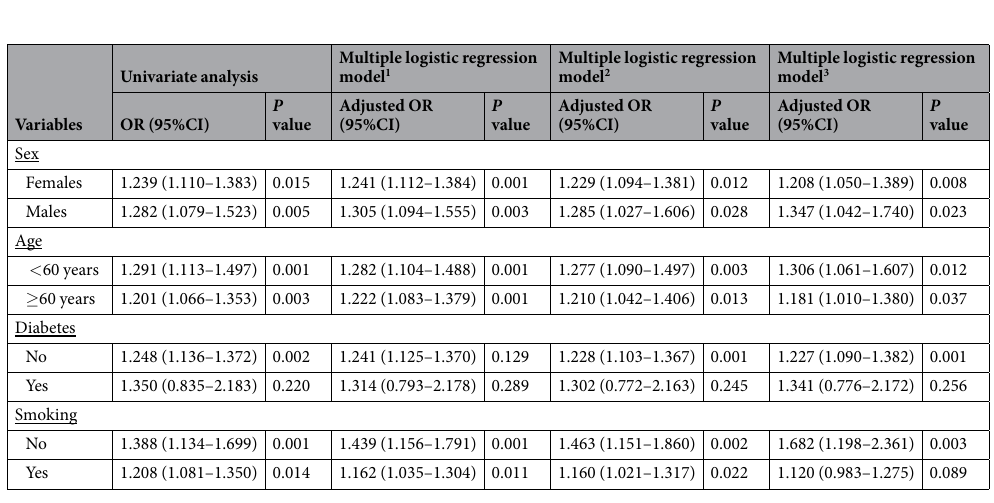
Table 5. Stratification analyses of plasma levels of LIPCAR with the risk of CAD. The model 1 included age, gender, BMI, and smoking. The model 2 included age, gender, BMI, smoking, hypertension, and diabetes. The model 3 included age, gender, BMI, smoking, hypertension, diabetes, TC, TG, LDL-C, and HDL-C. OR, odds ratio; CI, confidence interval.